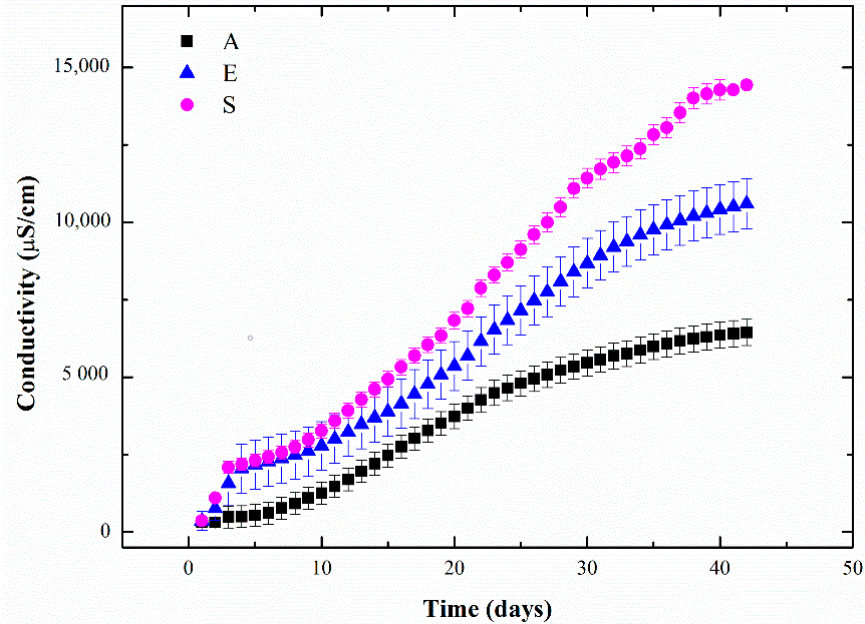
Figure 5. Micronutrient release study of the different matrices in soil: accumulation of conductivity in leachates with time.